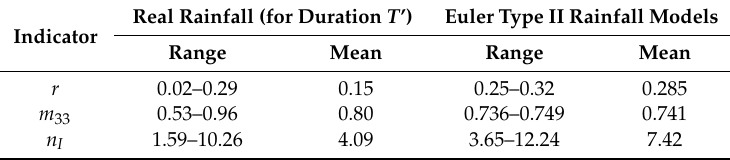
Table 2. Summary of mass distribution and unevenness in time parameters for real and Euler type II model